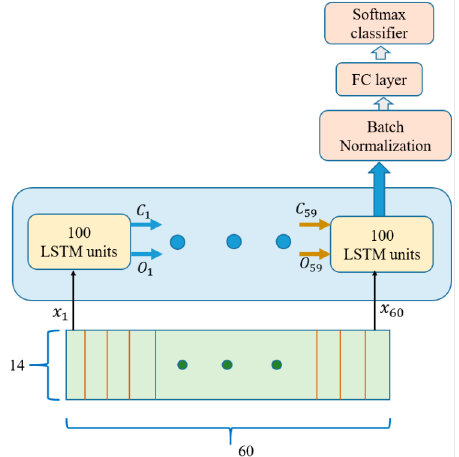
Figure 11. LSTM Network ( x = input, C = cell state, O = output, FC = fully